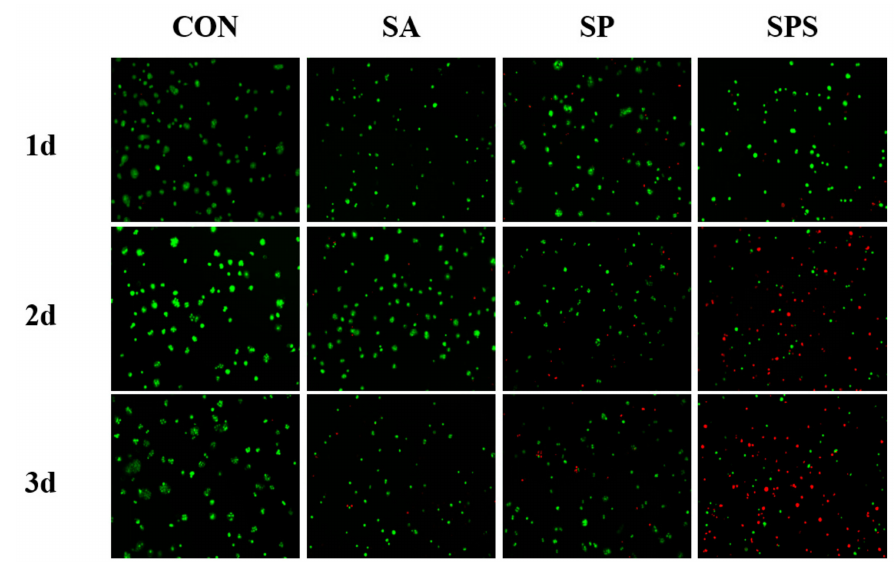
Figure 9. AO and PI staining images of colon cancer cells in the SPS, SP, SA and CON groups. (The green dots stained by AO indicate living cells, and the red dots stained by PI indicate dead or dying